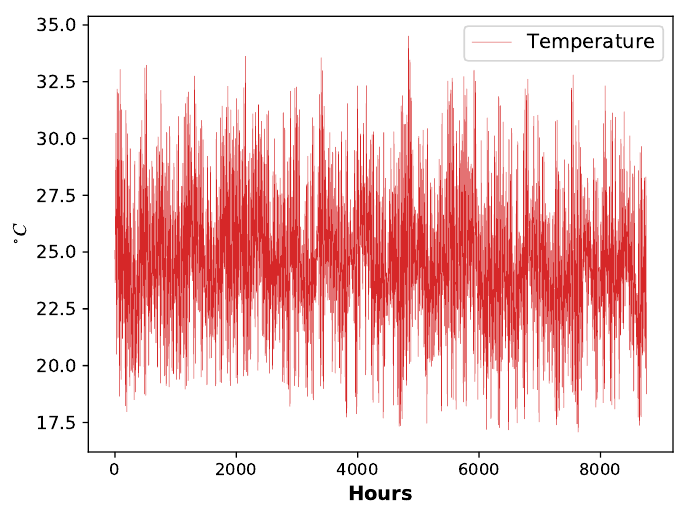
Figure 6. Yearly